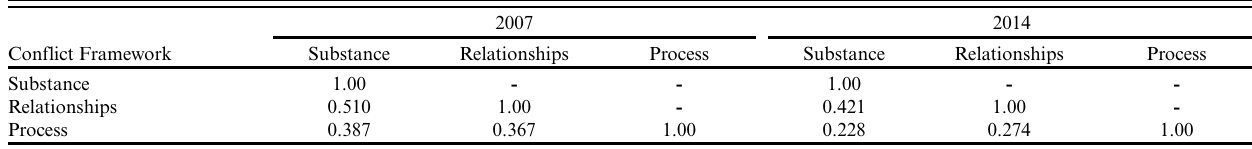
Table 5 . Correlation matrices of the substance, relationship, and process dimensions in 2007 and